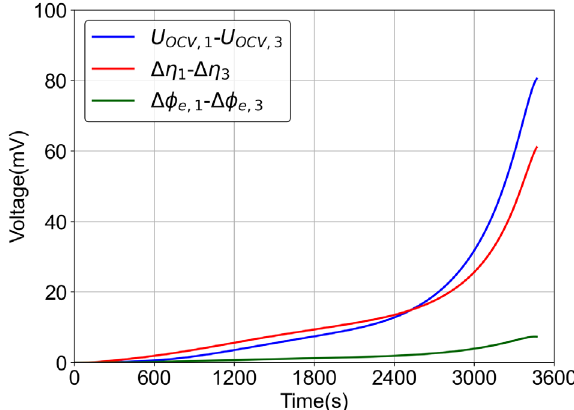
Figure 16. The difference of open-circuit voltage, the activation overpotential difference, and the electrolyte potential difference between cell 1 and cell 3 under the inhomogeneous cooling case 13.